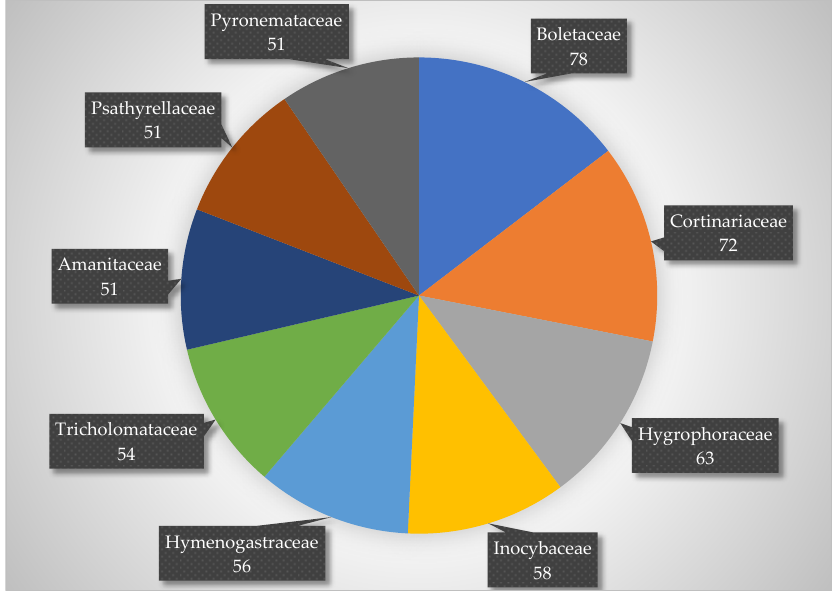
Figure 1. Most representative families with number of taxa greater than 50. The highest number of infraspecific taxa (Figure 2) is found in the province of Pa- lermo (1610) followed by in Messina (1546) and Catania (1517). The province with the lowest number of infraspecific taxa is Caltanissetta (330).